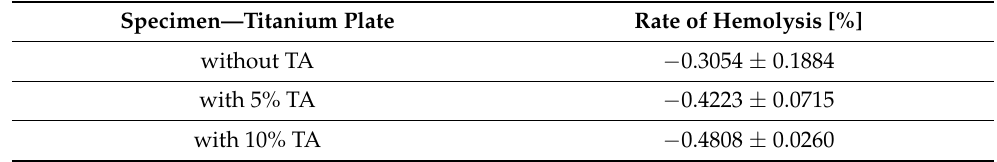
Table 2. Hemolysis rate for each type of titanium plate contacted with blood smears. Specimen—Titanium